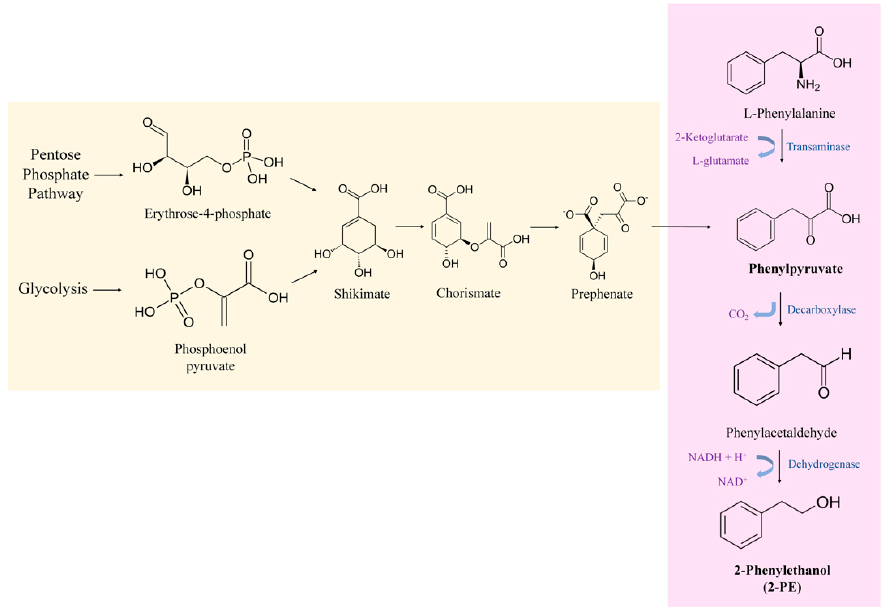
Figure 1. Metabolic pathways involved in the production of 2-PE in yeasts: Shikimate pathway for de novo synthesis of 2-PE and Ehrlich pathway for 2-PE production from L -Phe.